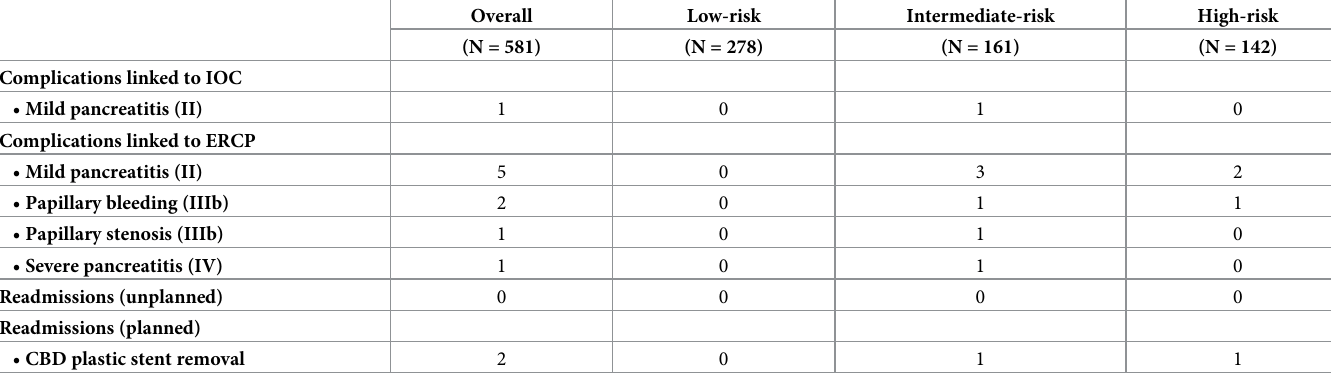
Table 3. Complications and